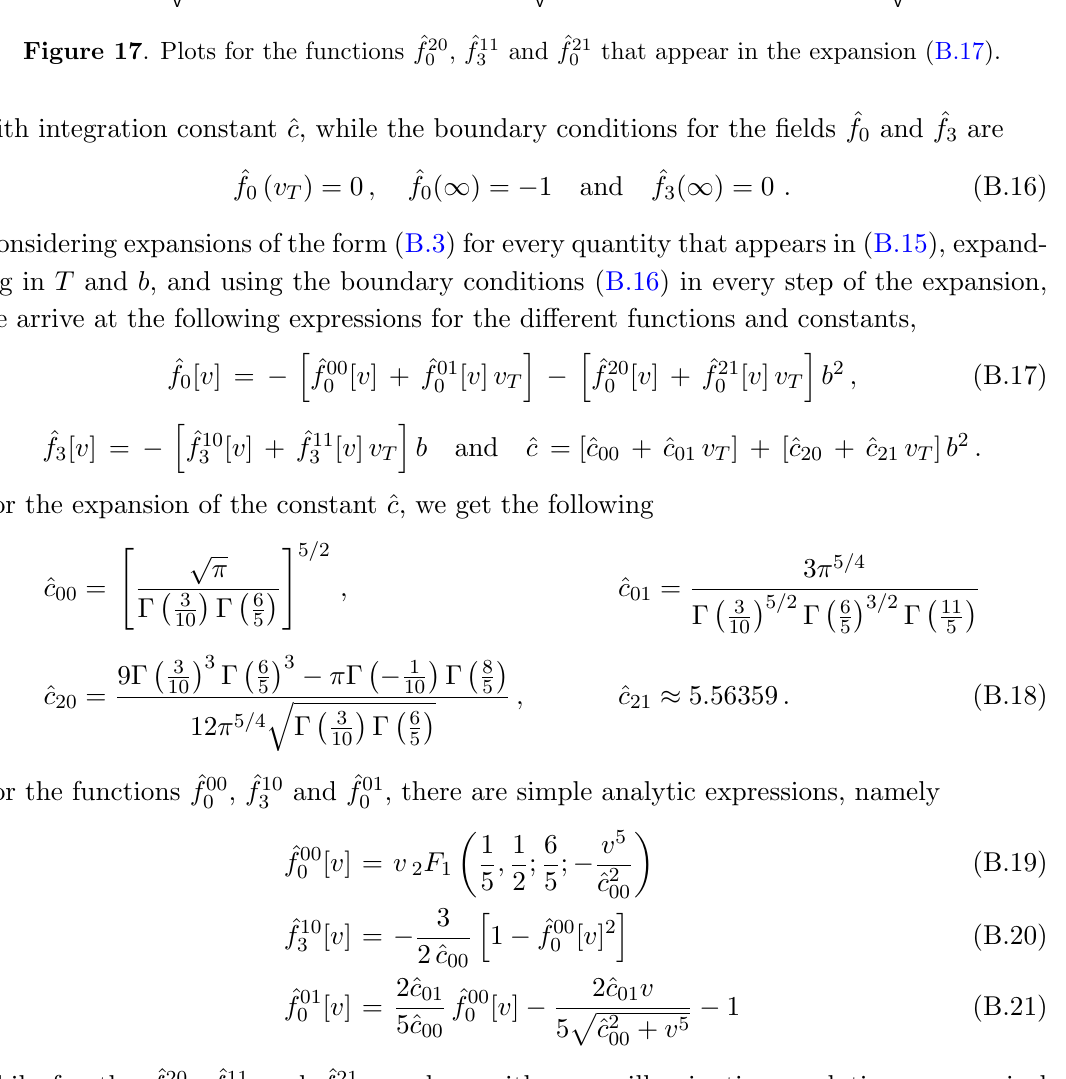
Figure 17 . Plots for the functions ^ f 20